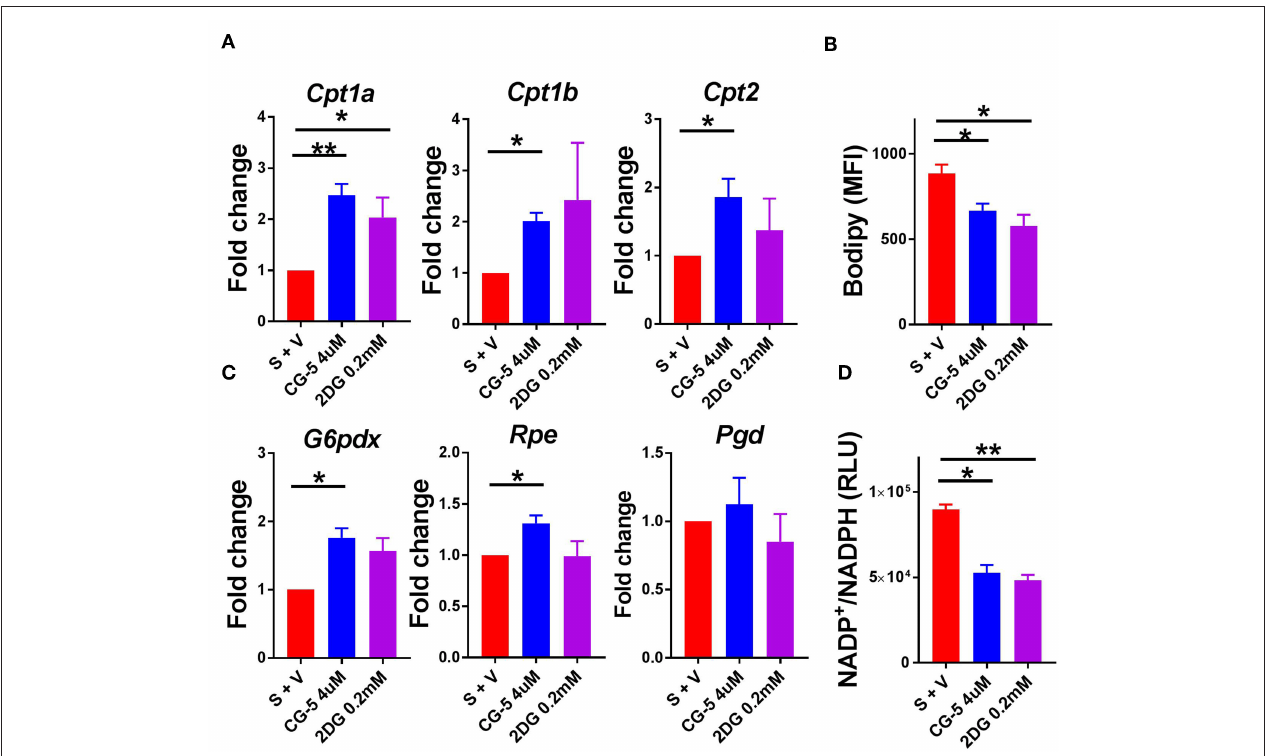
FIGURE 2 | CG-5 promotes FAO and PPP activation in CD4 + T cells. B6 CD4 + T cells were stimulated with anti-CD3/CD28 mAb in the presence of vehicle (S + V), CG-5, or 2DG for 24h. (A) Relative expression of FAO genes, Cpt1a , Cpt1b , and Cpt2 , normalized to vehicle-treated group. (B) Cellular lipid measured as Bodipy staining by flow cytometry. (C) Expression of PPP genes, G6pdx , Rpe , and Pgd , normalized to vehicle-treated group. (D) NADP + /NADPH ratio in cell lysates (RLU, Relative light unit). Mean ± S.E.M of n = 3–6 per group. * p < 0.05; ** p <